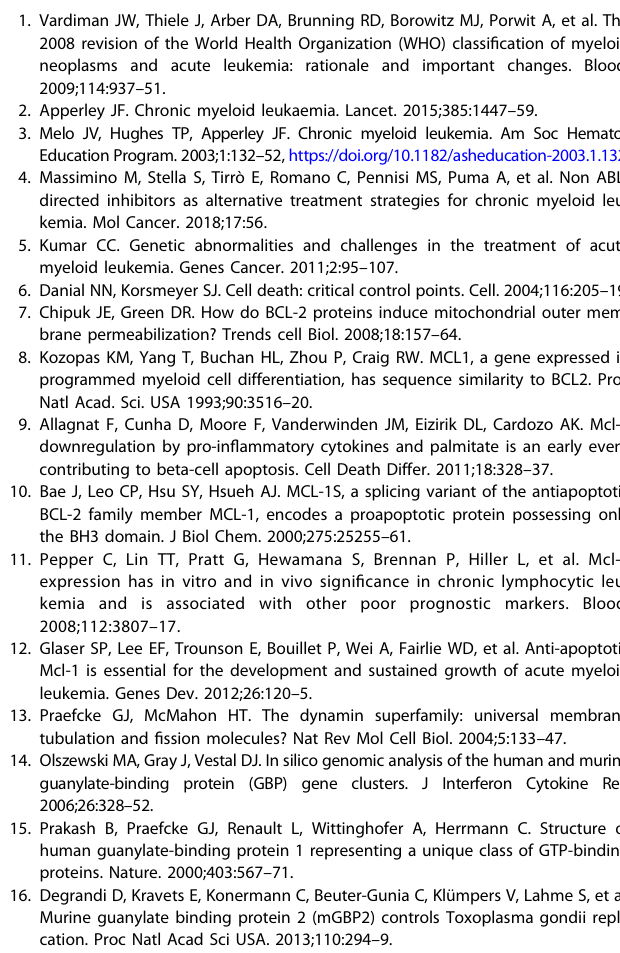
Fig. 6 GBP s are downregulated in leukemia patients and associated with leukemia prognosis. a The mRNA expression (log2) data of the U133Plus2 platform were obtained from the gene expression across normal and tumor tissue (GENT2) portal (http://gent2.appex.kr/gent2/). The speci fi c subtypes of leukemia-related datasets were selected for the gene expression study. Boxplot graphs of the expression levels of GBPs in normal tissue and speci fi c leukemia subtypes (AML, ALL, and CLL) were constructed, and one-way ANOVA was used for statistical analysis. The box plot represents the lower, median, and upper quartiles, and the whiskers represent the 95% con fi dence interval of the mean. The sample sizes of each gene group were indicated in the fi gure. Asterisks indicate statistically signi fi cant differences (** P < 0.01; *** P < 0.001). b To study the correlation of BAK and GBP s, the Pearson correlation coef fi cient was used to assess the co-expression of GBP2 and BAK genes in AML patients by analyzing the paired microarray data of AML patients extracted in ( a ). The estimated regression lines